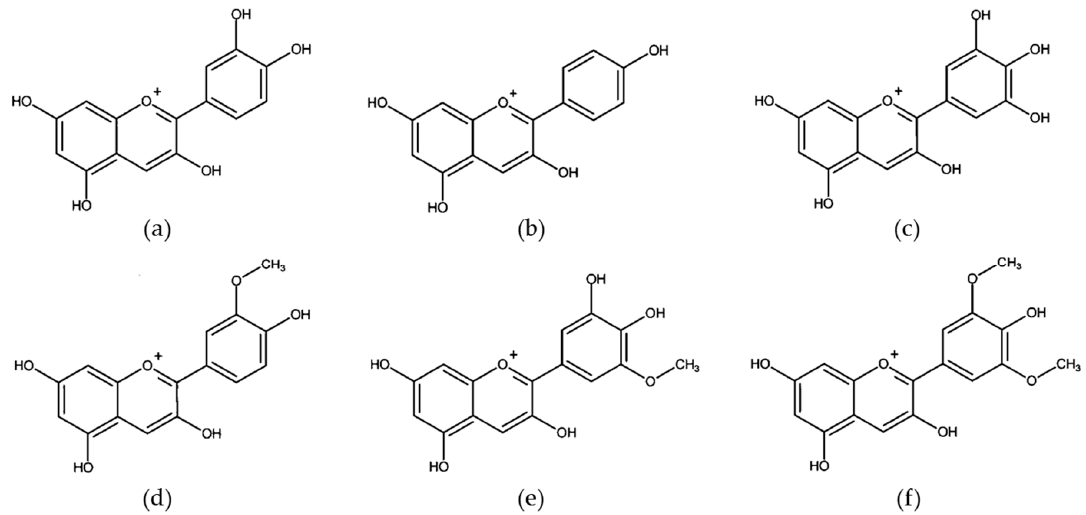
Figure4. Themostfrequentanthocyanidins. ( a )cyanidin, ( b )pelargonidin, ( c )delphinidin, ( d )peonidin, Figure 4. The most frequent anthocyanidins. ( a ) cyanidin, ( b ) pelargonidin, ( c ) delphinidin, ( d ) ( e ) petunidin, ( f ) peonidin, ( e ) petunidin, ( f ) malvidin.